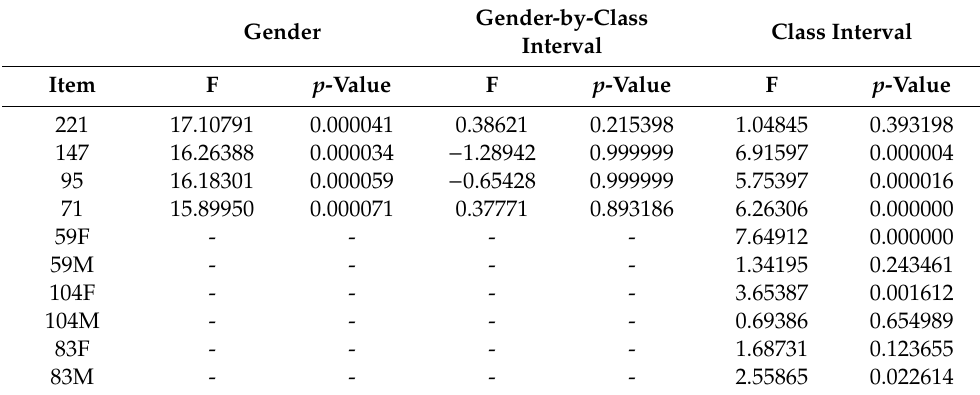
Table 2. Results ( α = 0.05; with Bonferroni correction: α = 0.000081) after resolving items 59, 104 and 83.